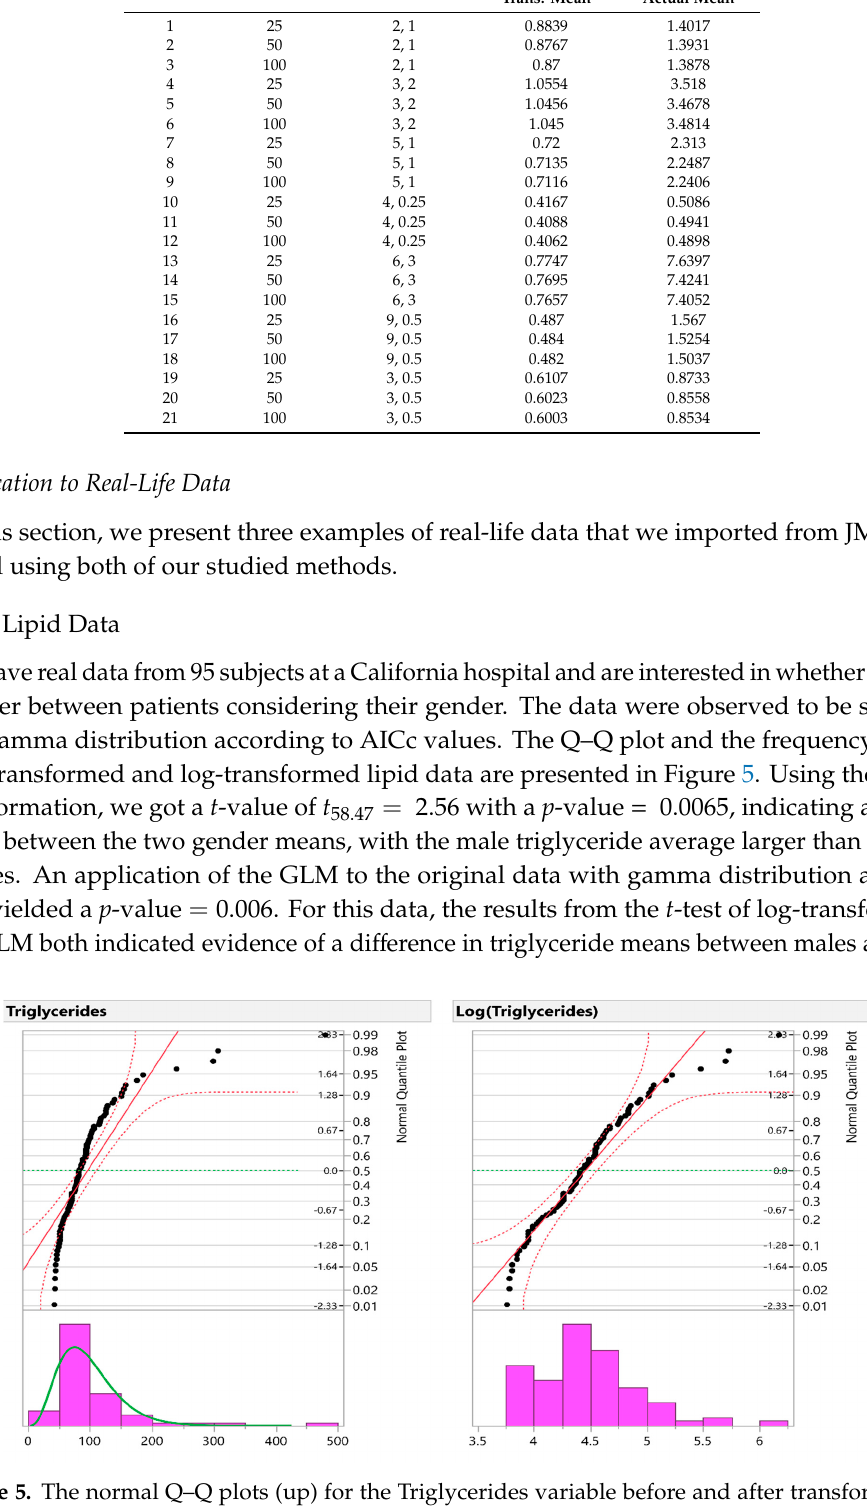
Figure 5. The normal Q–Q plots (up) for the Triglycerides variable before and after transformation and the frequency histogram of the Triglycerides variable on the left (down) is fitted with a gamma distribution (green).